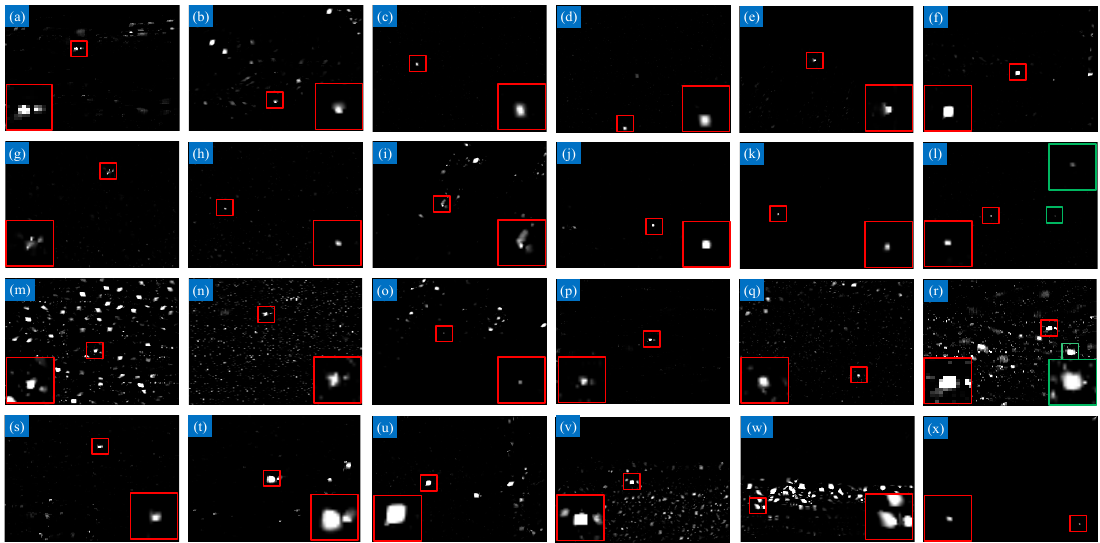
Figure A4. The separated target images of RLCM under 24 scenes.